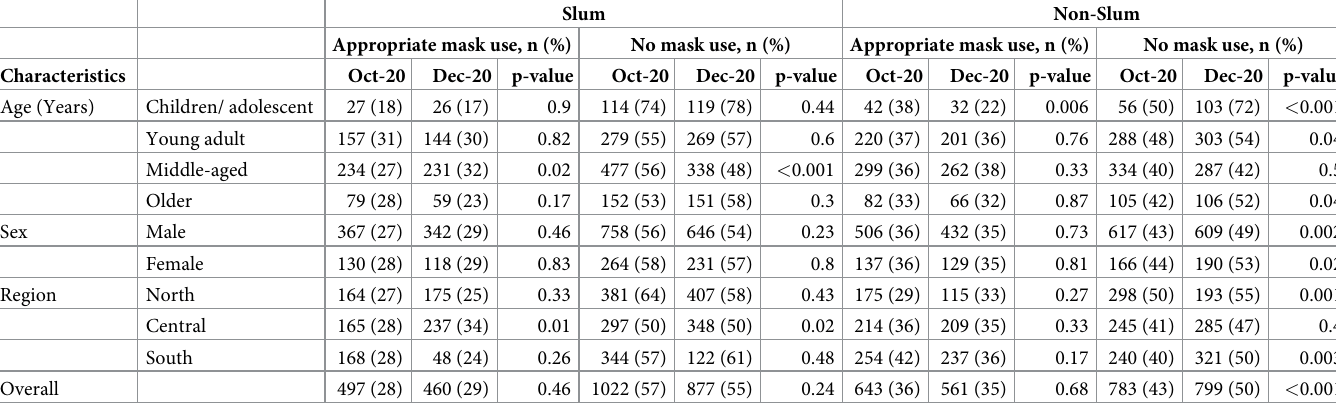
Table 3. Appropriate mask use and no mask use by rounds of surveys in the slum areas of Chennai, India,